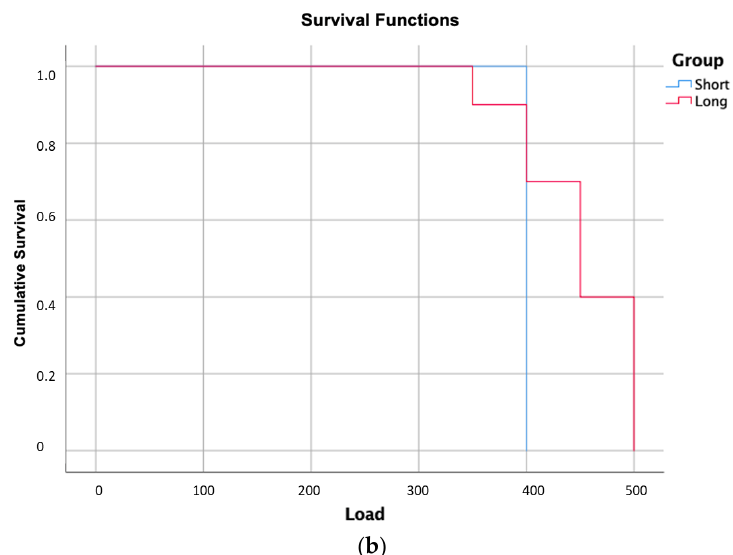
Figure 9. Survival graph of groups as a function of time (cycles) ( a ) and function load (N) ( b ). Table 5. Probability of survival of experimental groups according to applied load and number of steps (cycles). Total Cycles/Load (N)